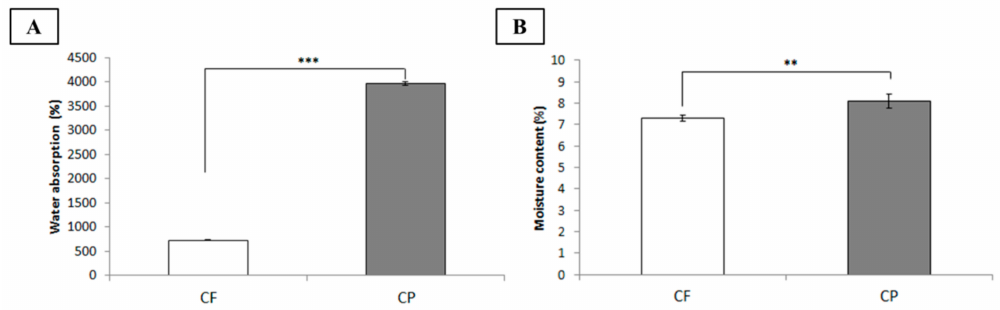
Figure 3. Water absorptivity of chitosan-based dressings, *** p < 0.001. ( A ) Water absorption. ( B ) Moisture content. (CF, chitosan fiber; CP, chitosan sponge), ** p <